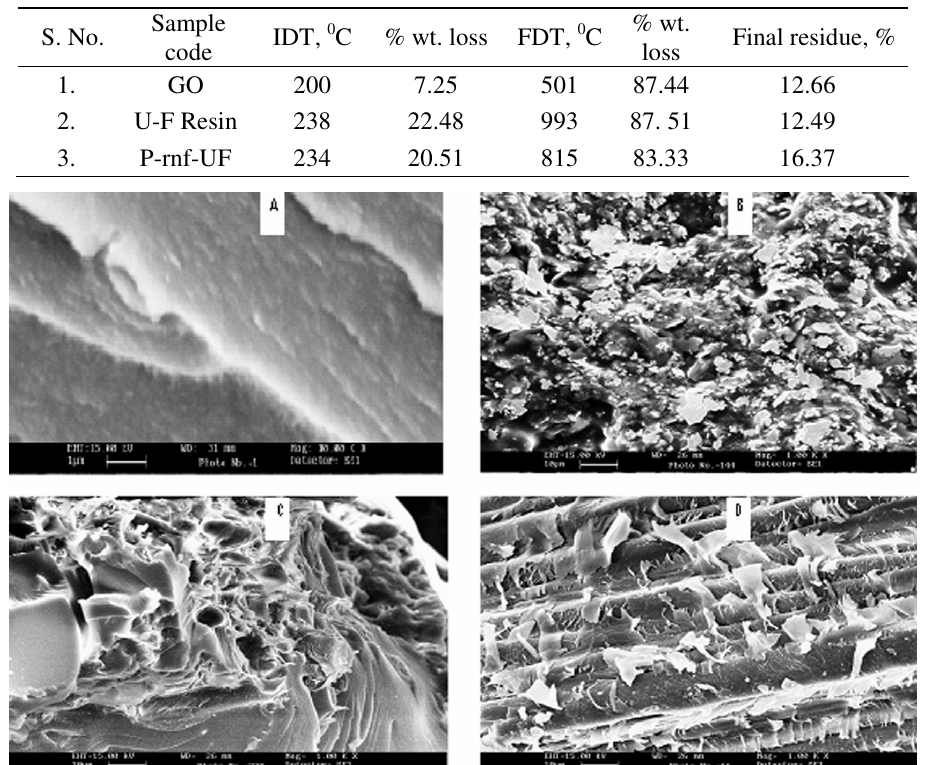
Table 2. Differential thermal analysis of HS, UF and P -Rnf-UF composites